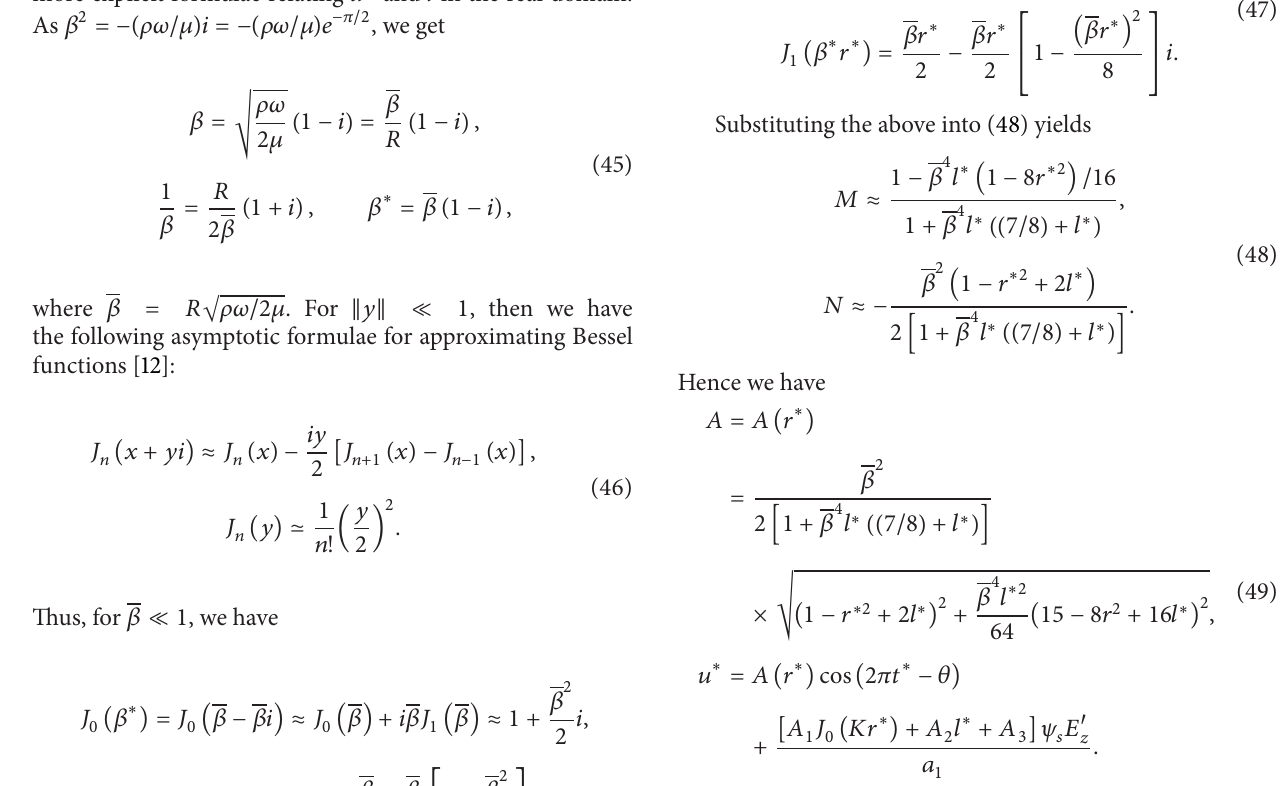
more explicit formulae relating 𝑢 ∗ and 𝑙 in the real domain.